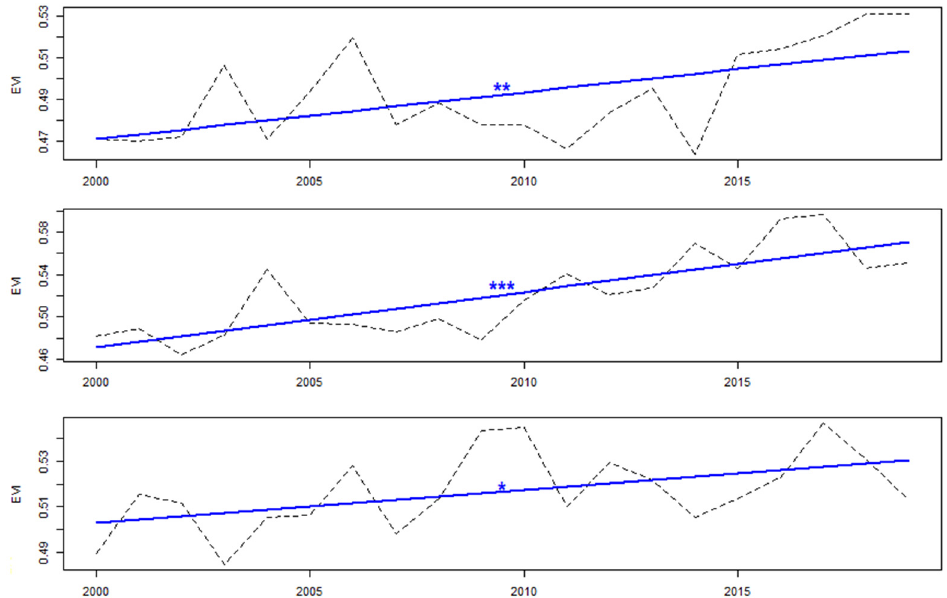
Figure 8. Trend (blue line) of annual peaking magnitude for mosaic areas. The symbol * shows the trend is significant, * has p value less than 0.05, ** has p value less than 0.005, and *** has p value less than 0.000001.